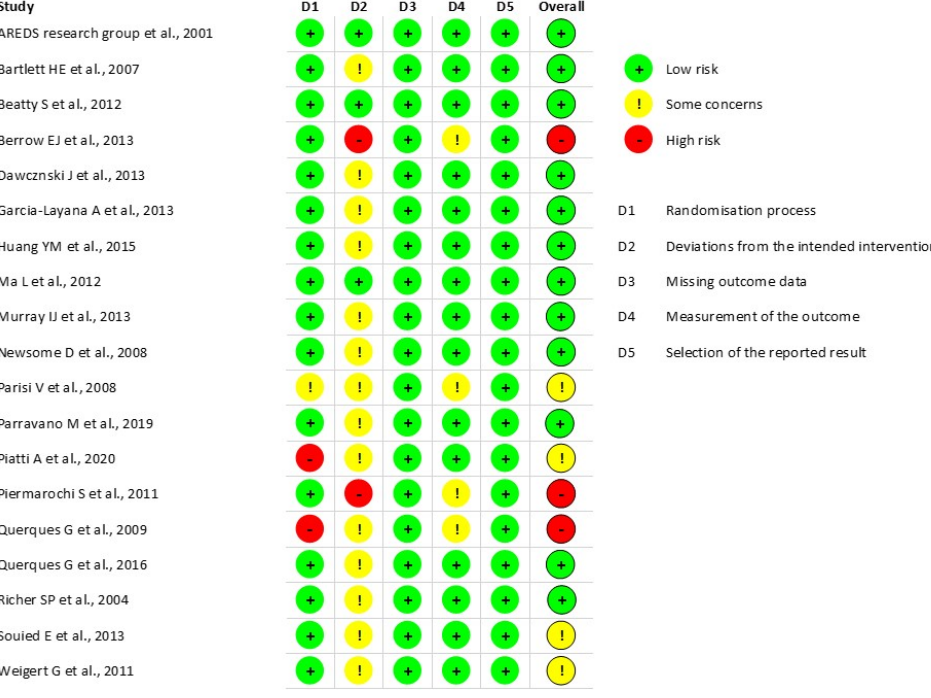
Figure 2. Quality assessment of all randomized controlled trials